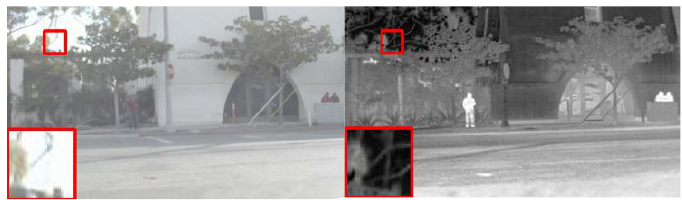
Figure 10. Source image of LGOE cascade comparison experiment.